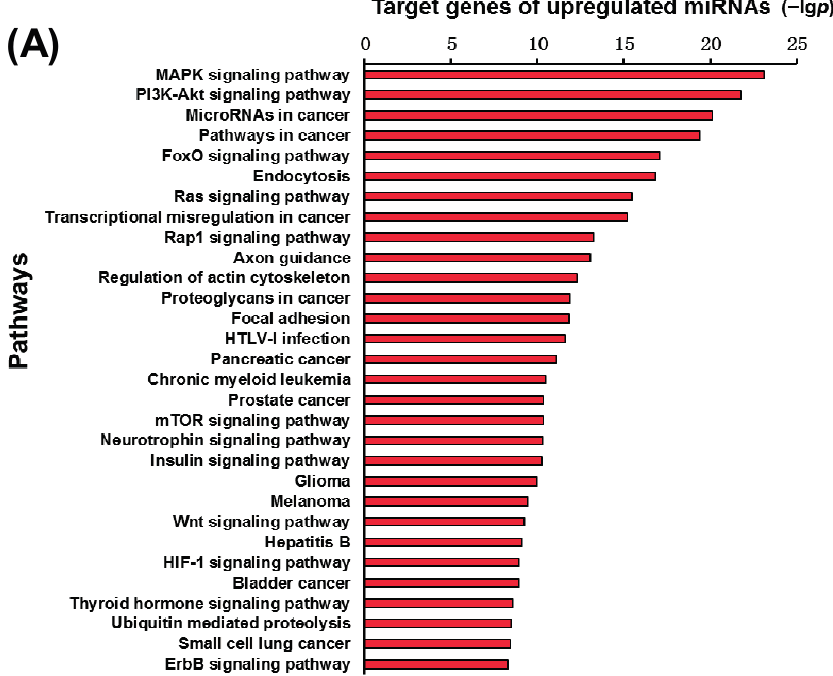
Figure 5. Target genes of the up-regulated miRNAs ( A ) and down-regulated miRNAs ( B ) annotated significant GOs. The vertical and horizontal axes are the GO terms and the − lg p of GOs, respectively. lg p is the logarithm of the p value and p < 0.05 is considered